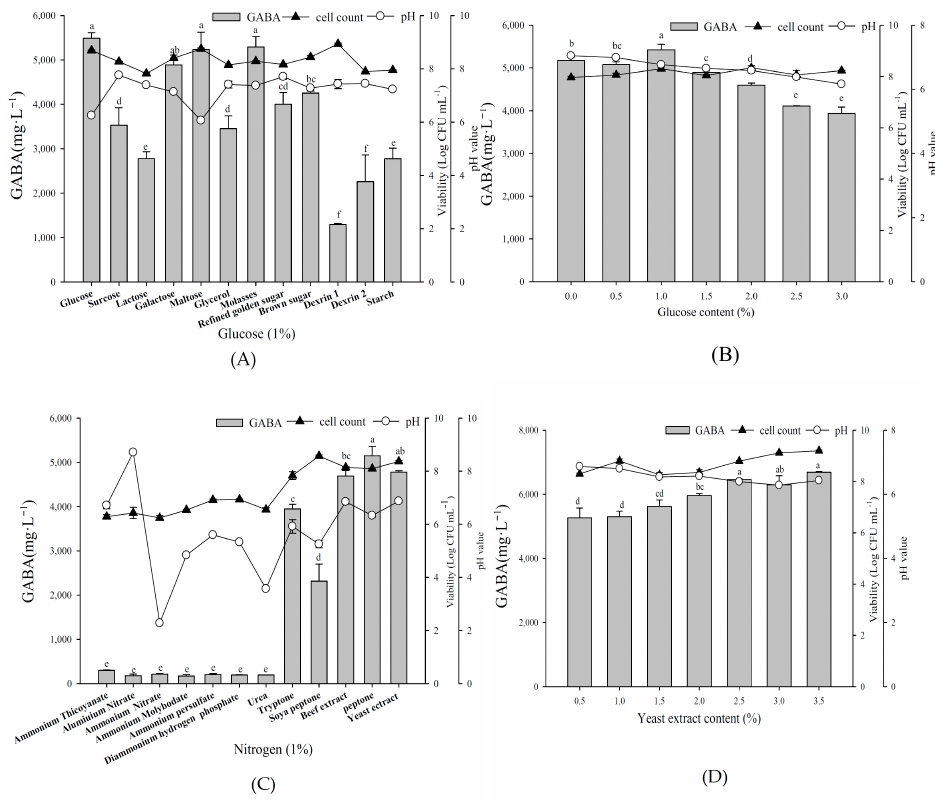
Figure 2. The effects of various carbon and nitrogen sources on GABA production by L. brevis RK03. Bacterial cells were grown with: ( A ) different carbon sources at 1%, 1% yeast extract and 1% MSG; ( B ) different percentages of glucose, 1% yeast extract, and 1% MSG; ( C ) different organic nitrogen sources at 1%, 1% glucose, and 1% MSG; and ( D ) different percentages of yeast extract, 1% glucose, and 1% MSG at 30 °C for 96 h. Different lowercase letters indicate statistically significant differences of GABA production. These data represent two different separate experiments. Data are expressed as mean ± SD from triplicate experiments. Different letters at the top of the bars are significantly different ( p < 0.05).